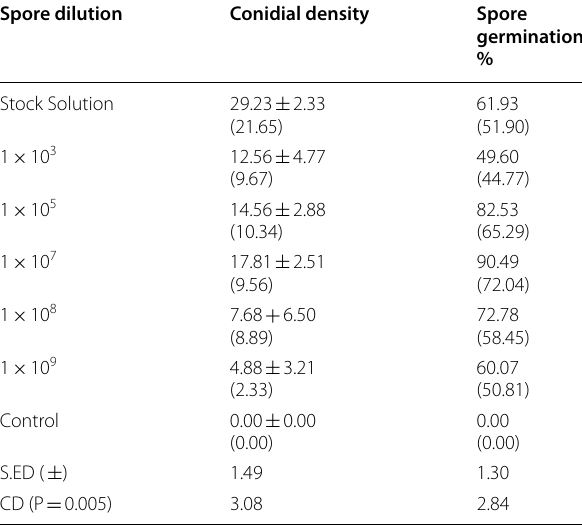
Data are mean of 7 replications. Data within the parentheses are angular transformed